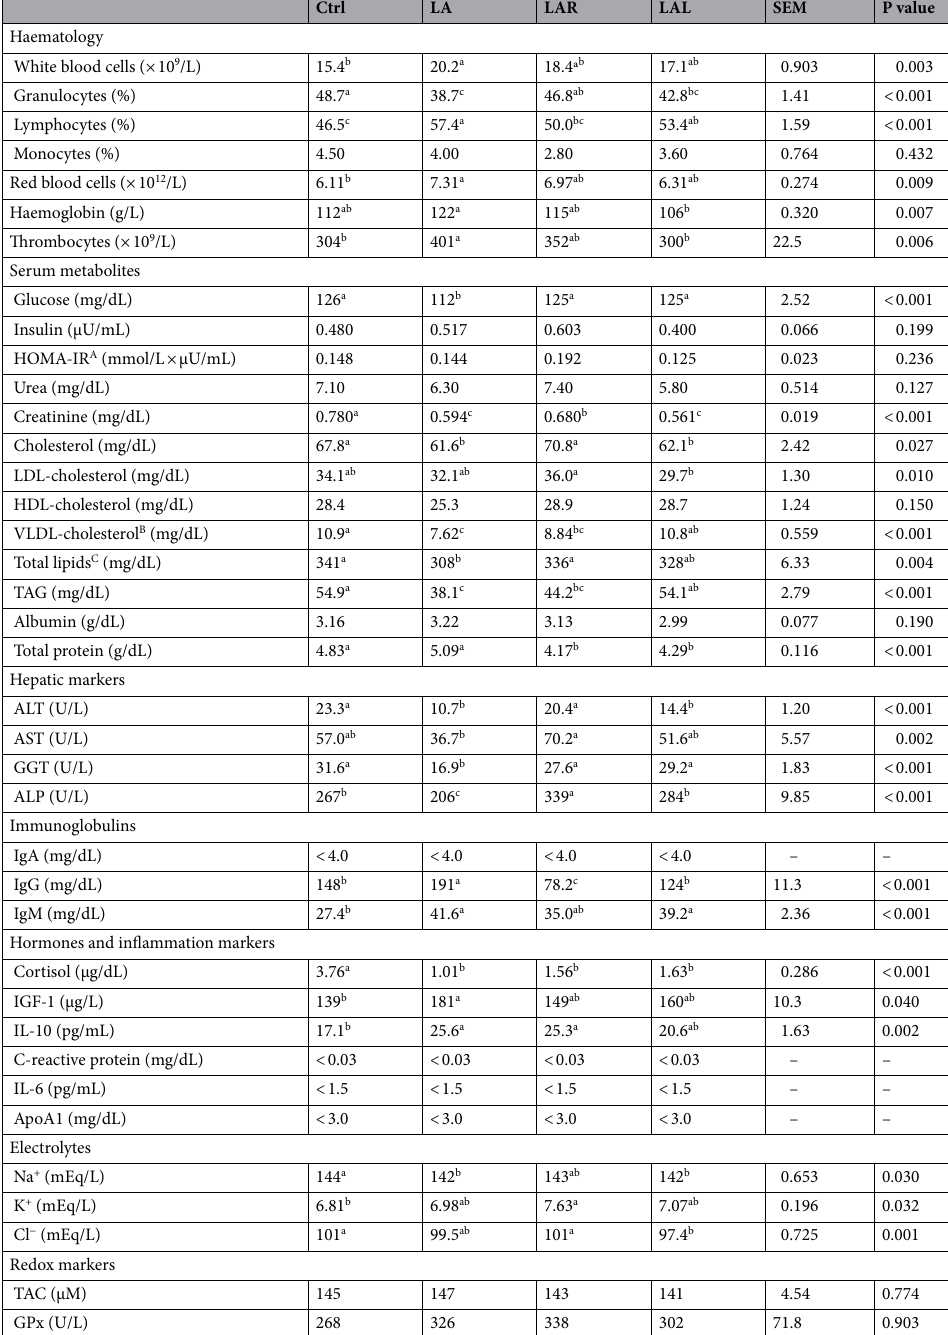
Table 1. Effect of dietary treatments on haematologic and serologic profiles of pigs. Ctrl control diet, LA control + 10% Laminaria digitata , LAR LA + 0.005% Rovabio ® Excel AP, LAL LA + 0.01% alginate lyase, TAG triacylglycerols, HDL high-density lipoprotein, LDL low density lipoprotein, VLDL very low density lipoprotein, ALT alanine aminotransferase, ALP alkaline phosphatase, AST aspartate aminotransferase, GGT gamma-glutamyltransferase, IGF-1 insulin growth factor 1, IL-10 interleukin 10, IL-6 interleukin 6, IgG immunoglobulin G, IgM immunoglobulin M, ApoA1 apolipoprotein A1, SEM standard error of the means. Values with different superscripts are significantly different at P < 0.05. A HOMA-IR, insulin resistance index = [fasting serum glucose] × [fasting serum insulin]/22.5. B VLDL-cholesterol = 1/5 (TAG). C Total lipids = (total cholesterol) × 1.12 + (TAG) × 1.33 +